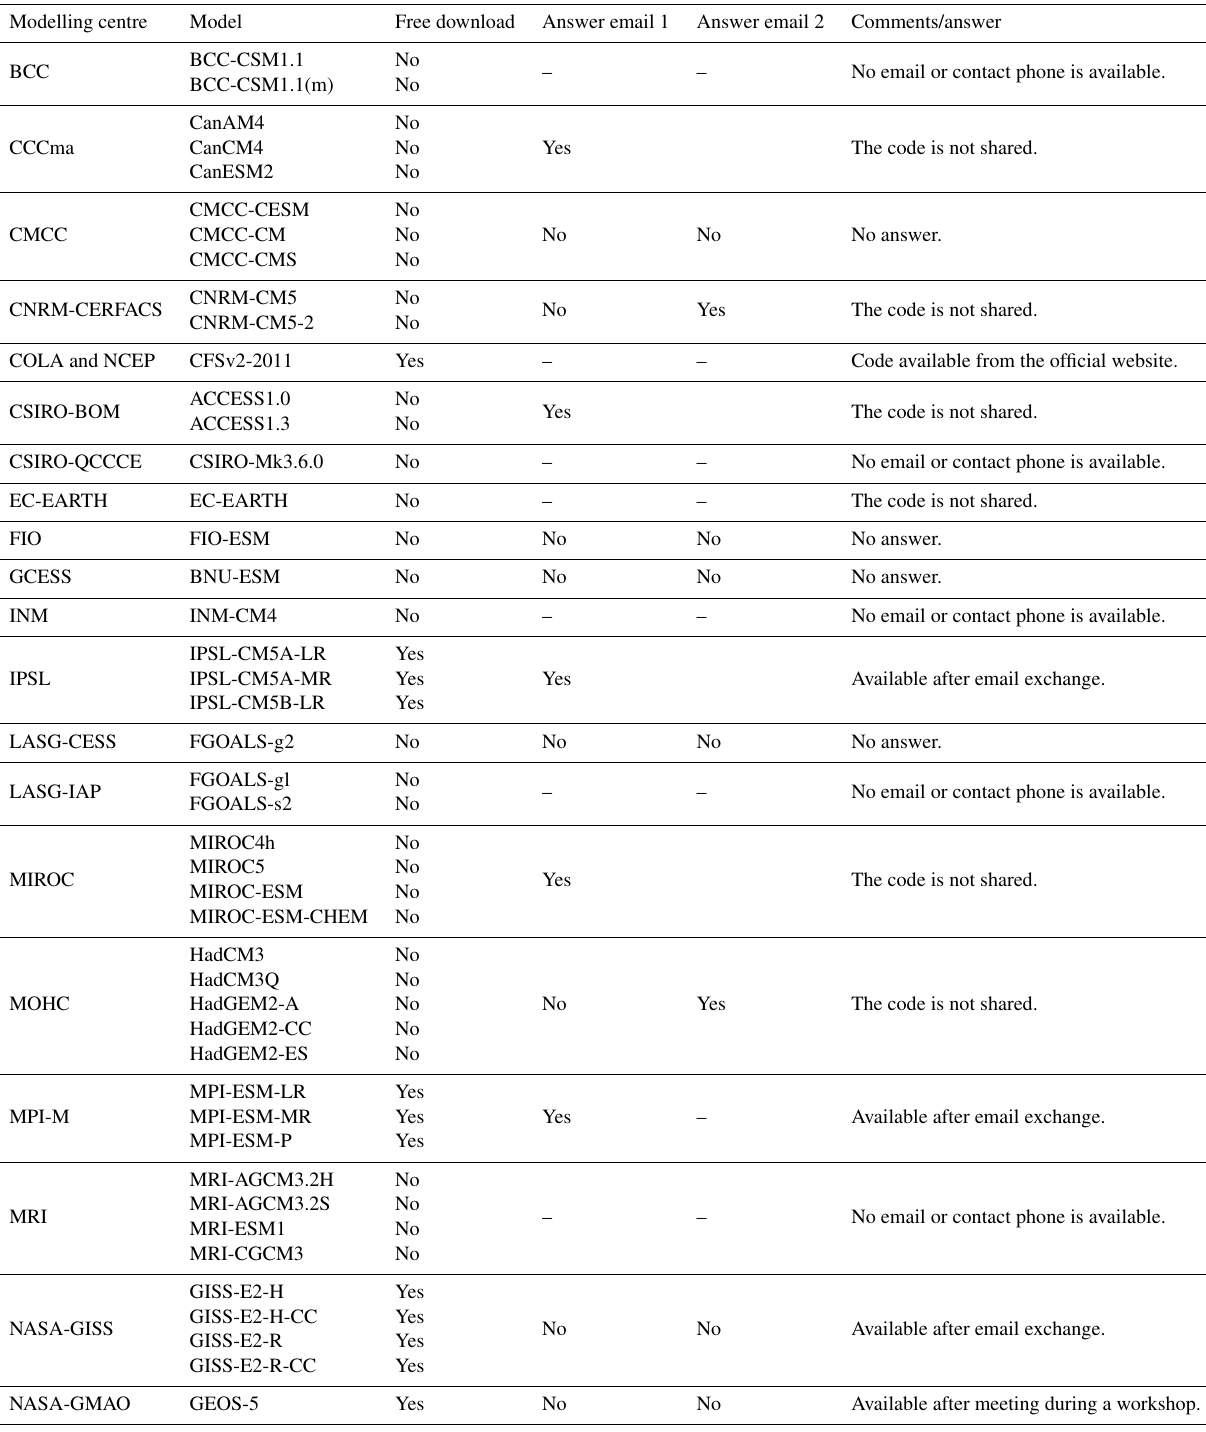
Table 1. CMIP5 model list, research centre responsible for each model, and details on the procedure for accessing their code. Emails 1 and 2 can be found in Appendix A1. Email 3 (Appendix A2) is not listed because we did not receive any answers to this